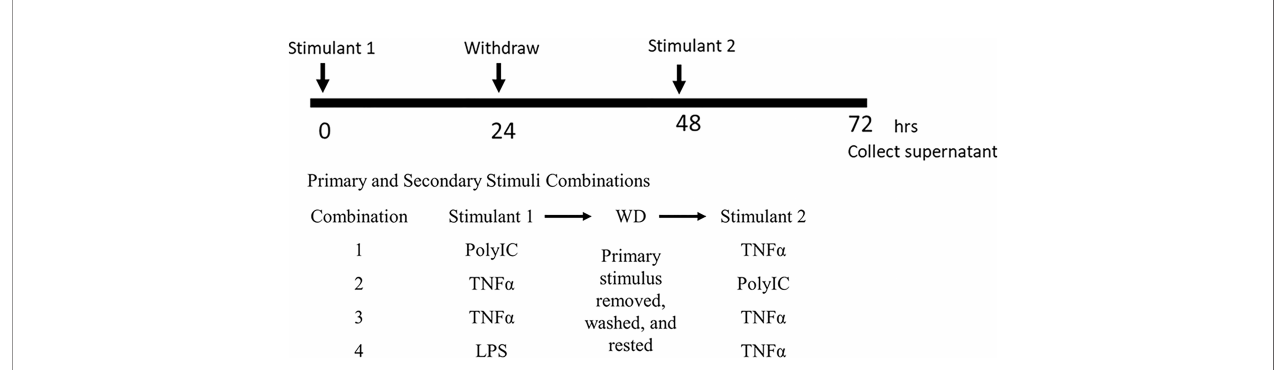
FIGURE 1 | Experimental treatment procedure. Different combinations of stimulants were utilized to investigate the presence of in fl ammatory memory in human lung fi broblasts. Withdrawal method means that stimulus 1 was removed, and cells were washed. TLR3 and NF- k B inhibitors were administered together with